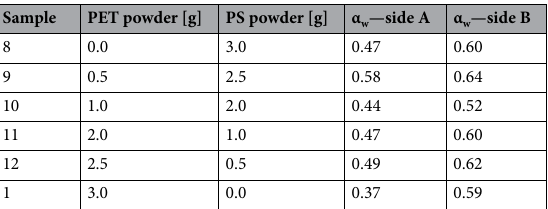
Table 9. Variations in averaged sound absorption coefficient with alterations in microplastics powder composition.